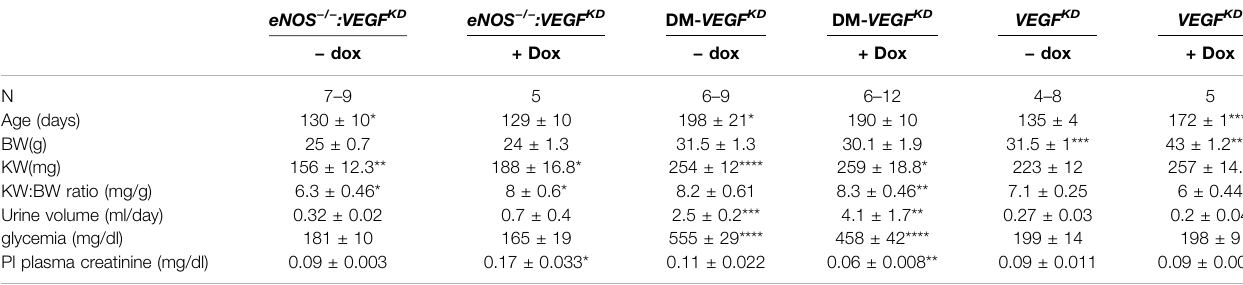
TABLE 1 | General parameters.